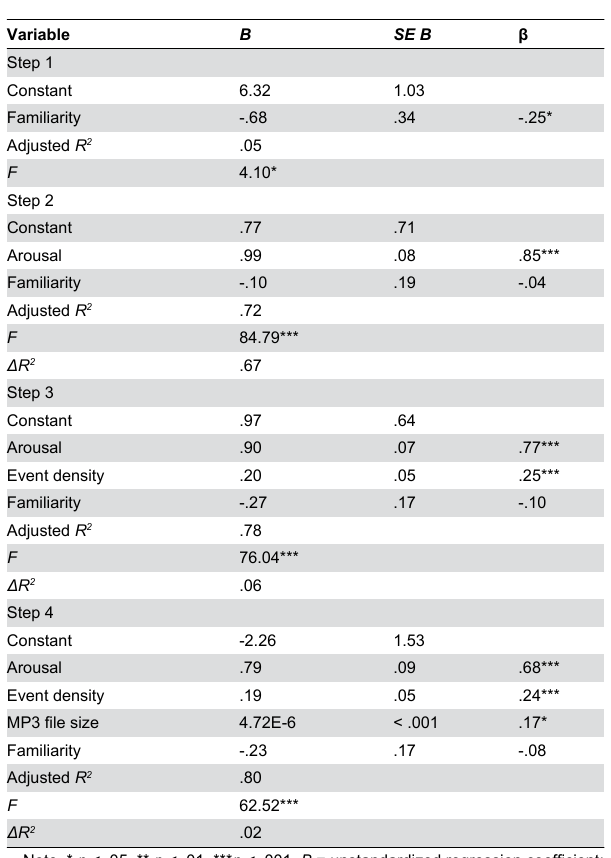
Table 16. Summary of linear stepwise regression analysis for seven variables predicting subjective complexity ratings of piano solo and piano trio excerpts (N =